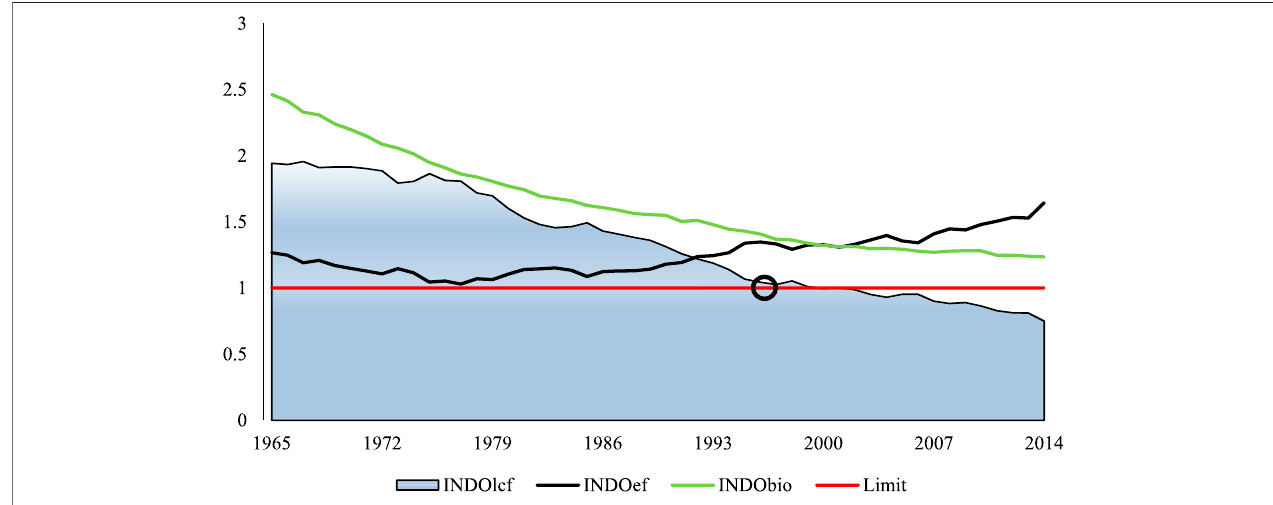
FIGURE 1 | Ecological situation in Indonesia. SOURCE: Global Footprint Network